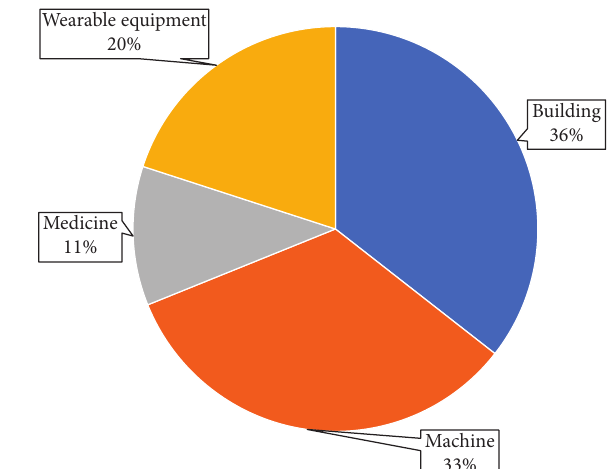
Figure 9: Application scenarios